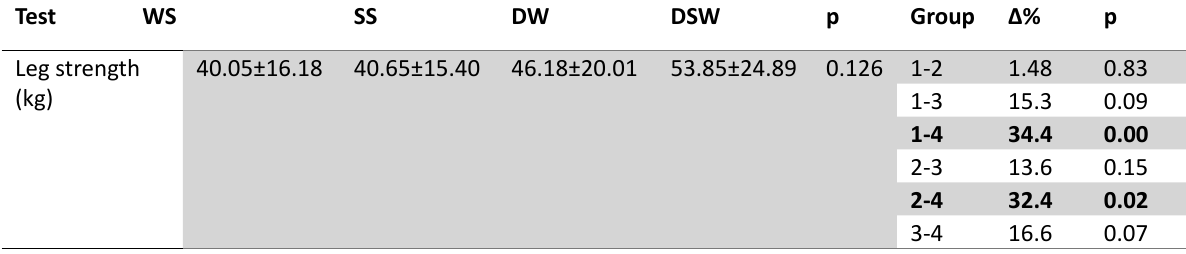
Table 3. Leg strength values and differences after different stretching and warm up protocols Test Leg strength